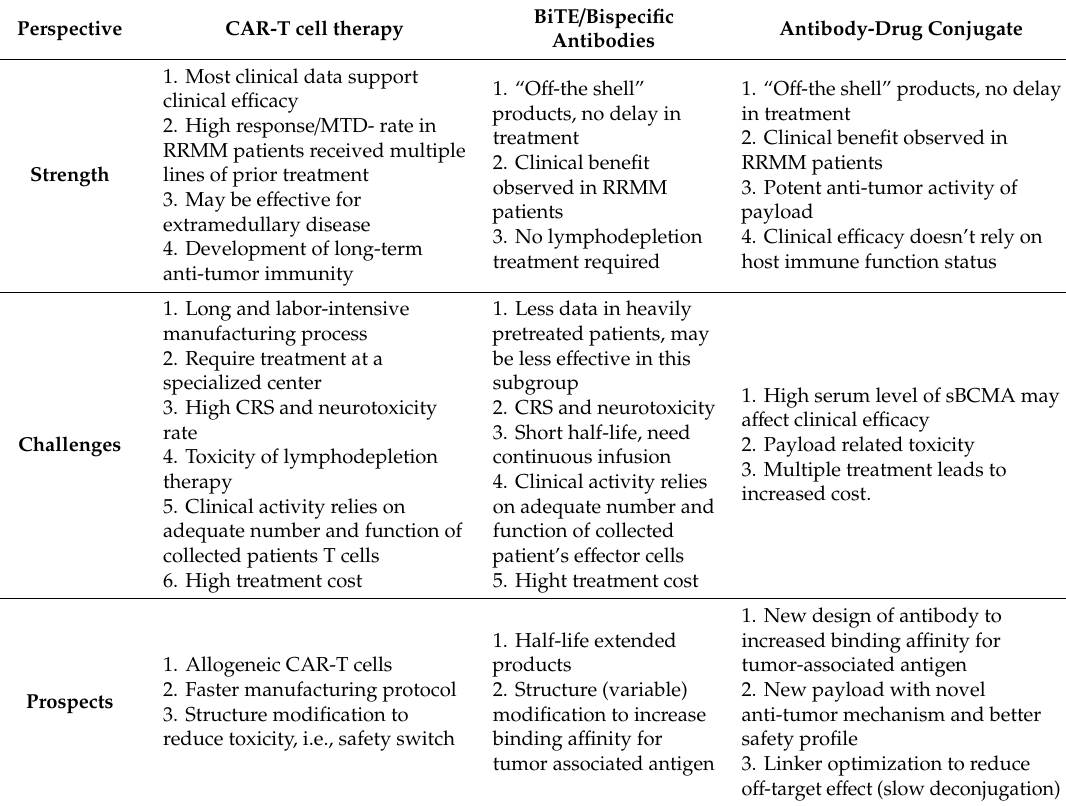
Table 3. Comparison of BCMA-based immunotherapeutic agents in an RRMM